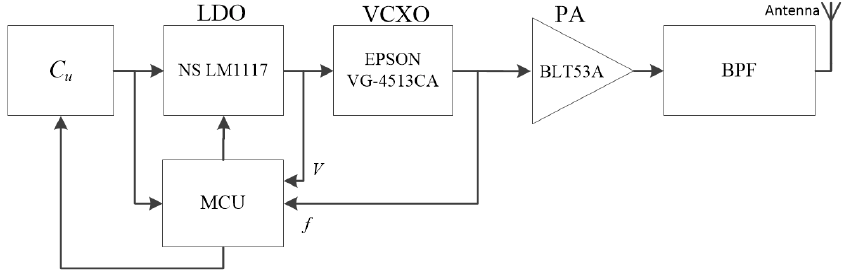
Figure 10. Structure of the energy transmitter.